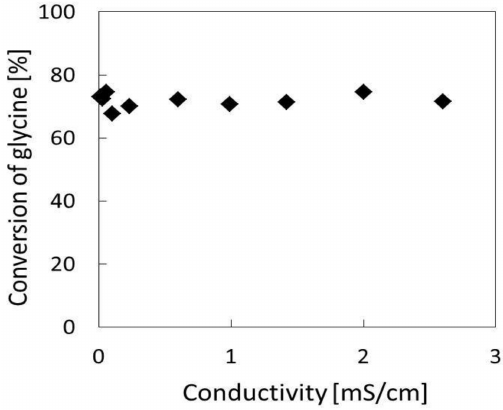
Figure 6. Effect of conductivity on glycine conversion in aqueous solution after 1000 discharge plasma pulses at 18.6 kV.